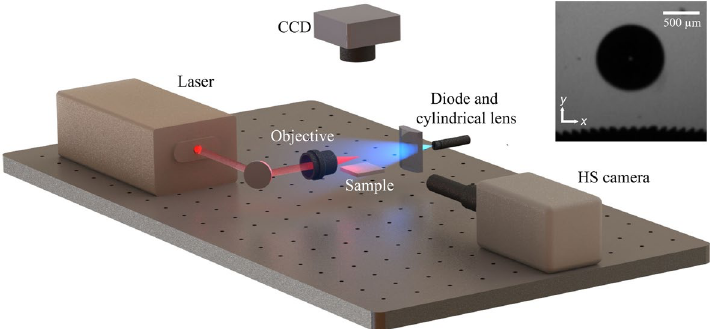
Figure 3. Schematic representation of the experimental setup to induce cavitation (cuvette not shown), record the bubble dynamics (white light not shown) and perform PTV visualization. Inset shows representative HS image of a cavitation bubble above a microstructured surface. Dark ridges seen at the bottom surface are the expanded EAPs.